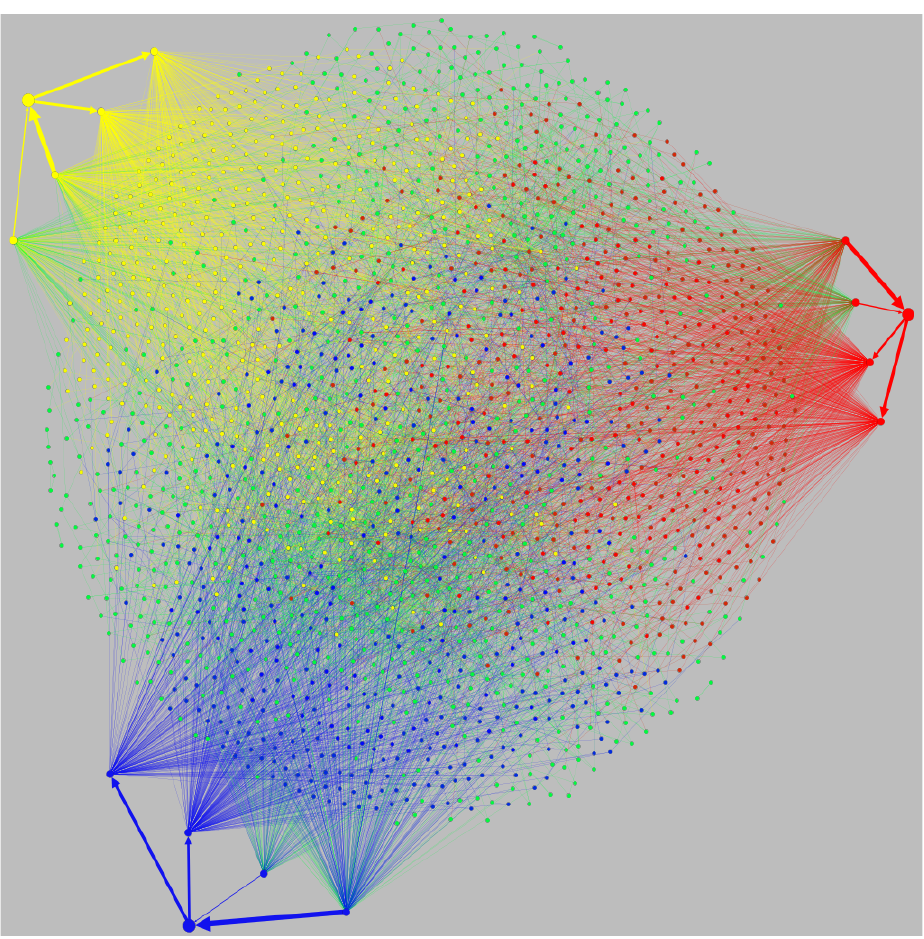
Figure 10. Visualization of payment system with three liquidity sources (EUBOF